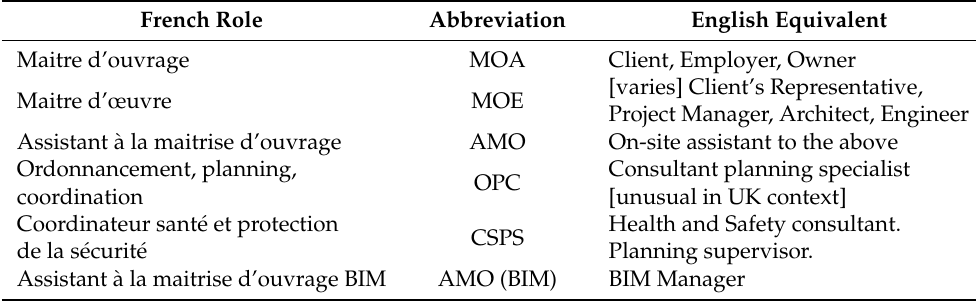
Table A1. French terminology for project actors with English